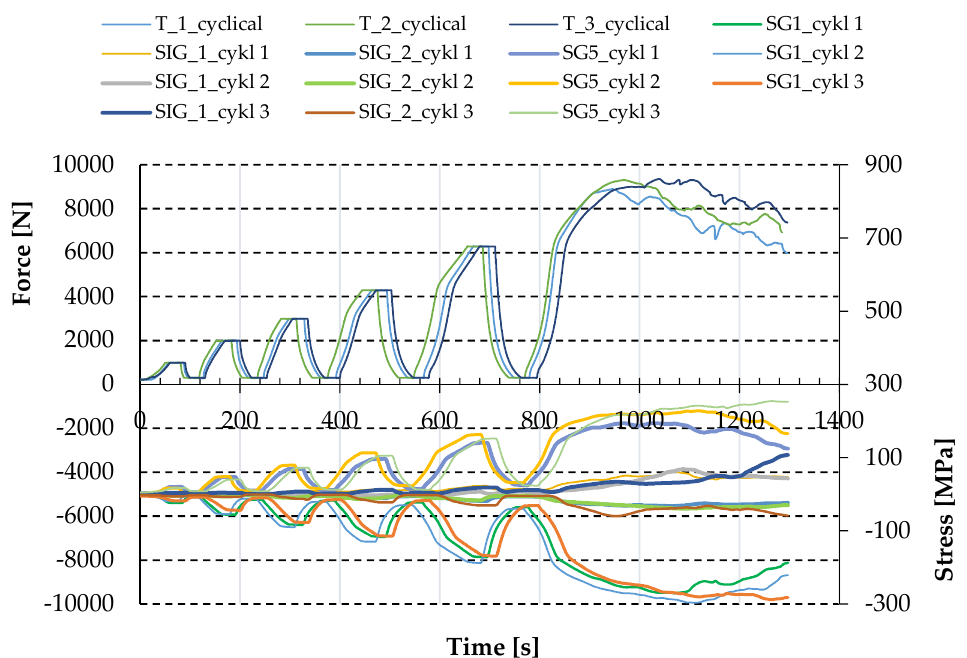
Figure 9. Force–time and stress–time paths obtained in experimental tests for repeated loading.